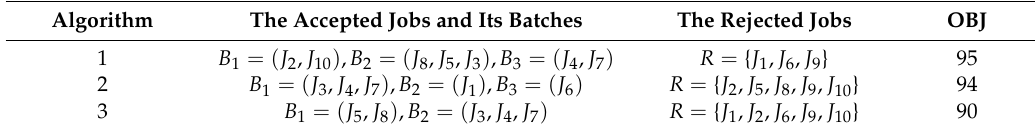
Figure 1. The makespan of the optimal solution.